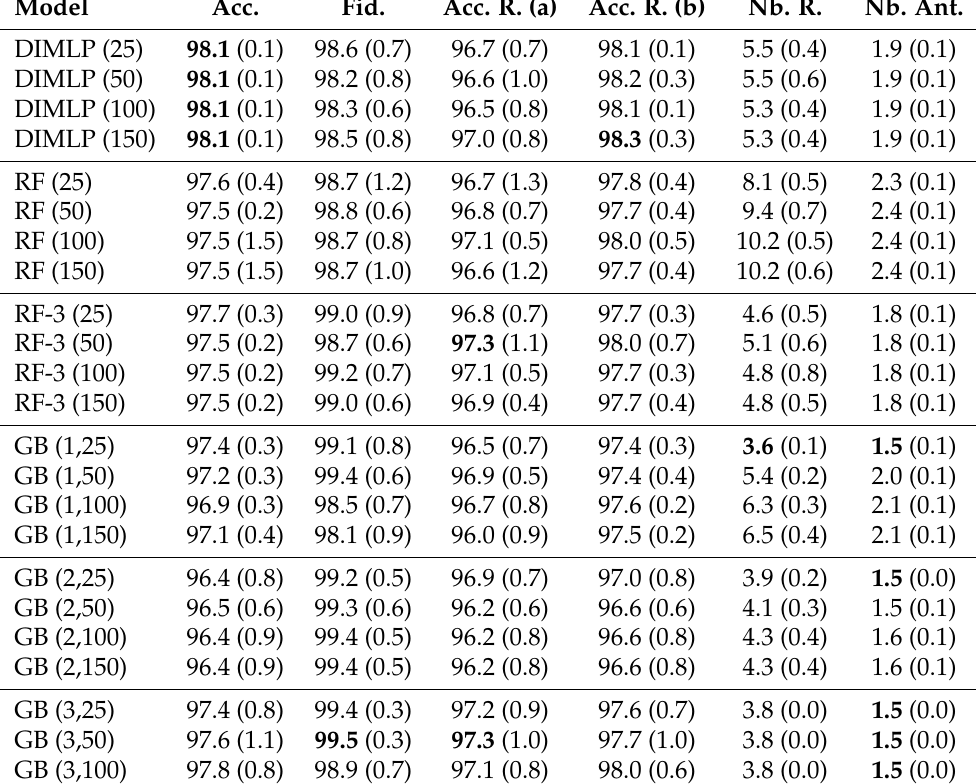
Table 4. Average results obtained on the “Divorce” dataset. For each column, the highest average accuracy or average fidelity is represented in bold, along with the lowest average number of rules or average number of